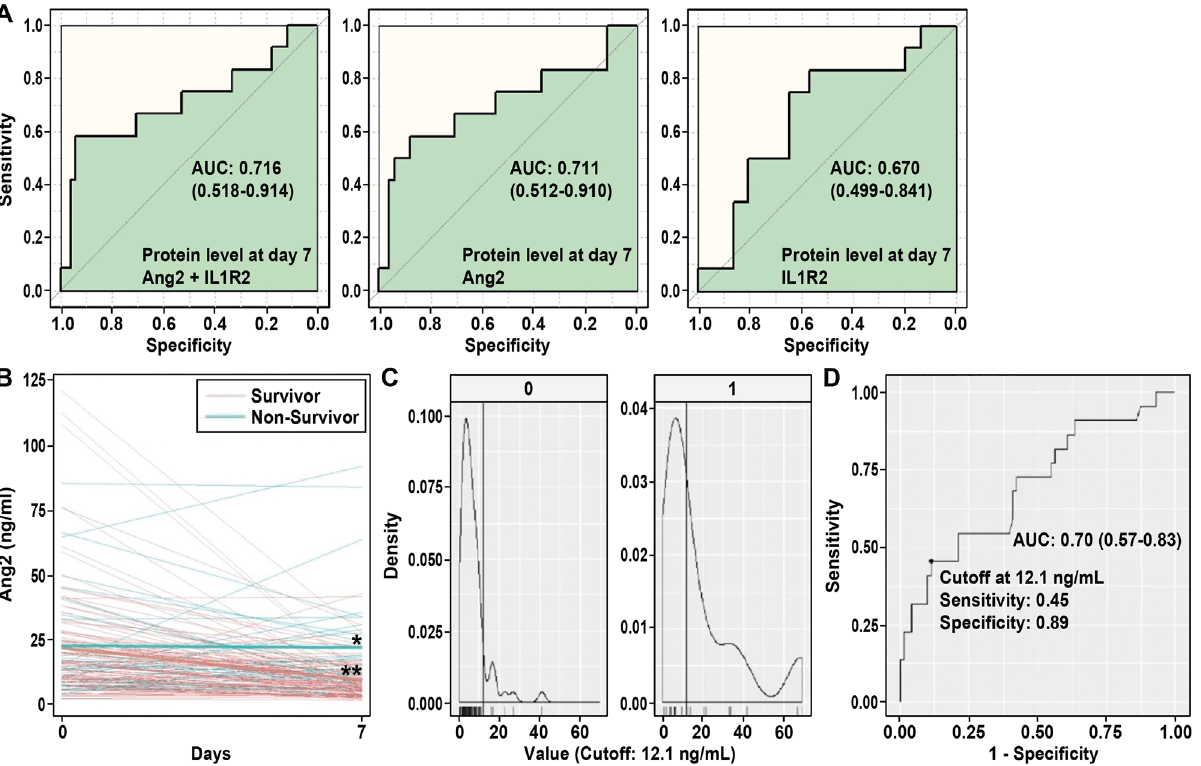
Figure 4. (A) AUC plots of the prediction model using Day 7 Ang2 and IL1R2 (alone and combined). Day 7 Ang2 alone has significant discrimination between ARDS survivor/non-survivor groups. ( B) Mean concentration of Ang2 in Day 0 (baseline) and Day 7 between ARDS survivor/non-survivor groups showed the mean concentration of Ang2 decrease with time in the survivor group. * Mean concentration for death; ** Mean concentration for survivors. ( C) Independent variable optimized cutoff and distribution by class (0 = alive, 1 = death); cutoff concentration of 12.1 ng/mL. ( D) ROC curve, sensitivity and specificity using Day 7 Ang2 protein level to predict ARDS mortality which showed with the cutoff concentration of 12.1 ng/mL, the specificity for ARDS mortality is high at